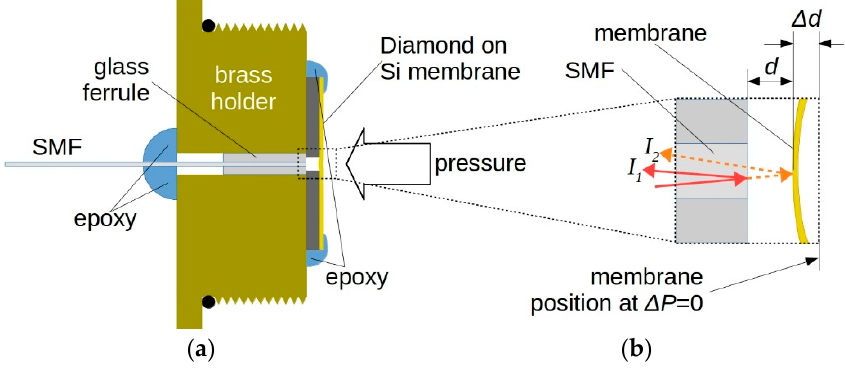
Figure 6. ( a ) Schematic of the sensor structure. SMF end-face and diaphragm represent the Fabry–Pérot cavity. ( b ) Interference signal is generated by the reflected signal at the fiber end (light intensity I 1 ) and diamond membrane (light intensity I 2 ). The cavity length d depends on the pressure difference Δ P on the two membrane surfaces, creating a displacement Δ d from the position when the same ambient pressure is applied.